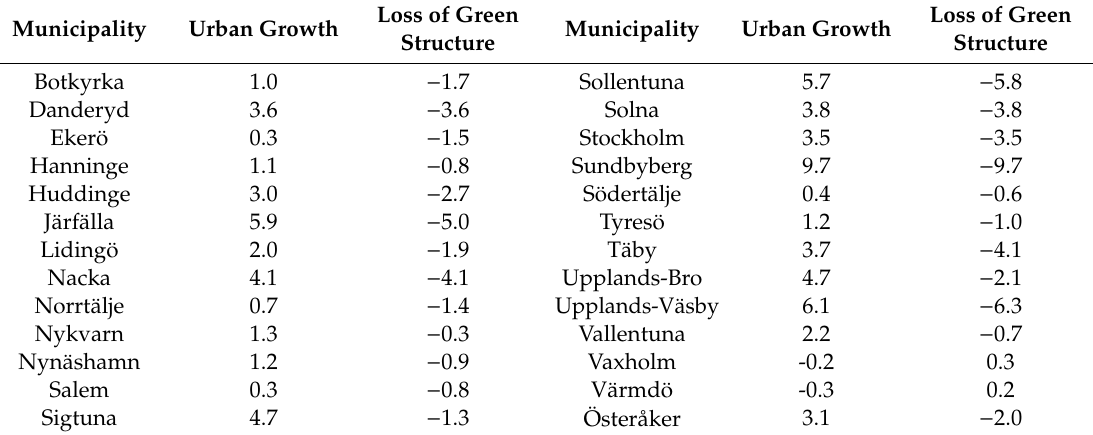
Table 7. Urban and green structure percentage changes per